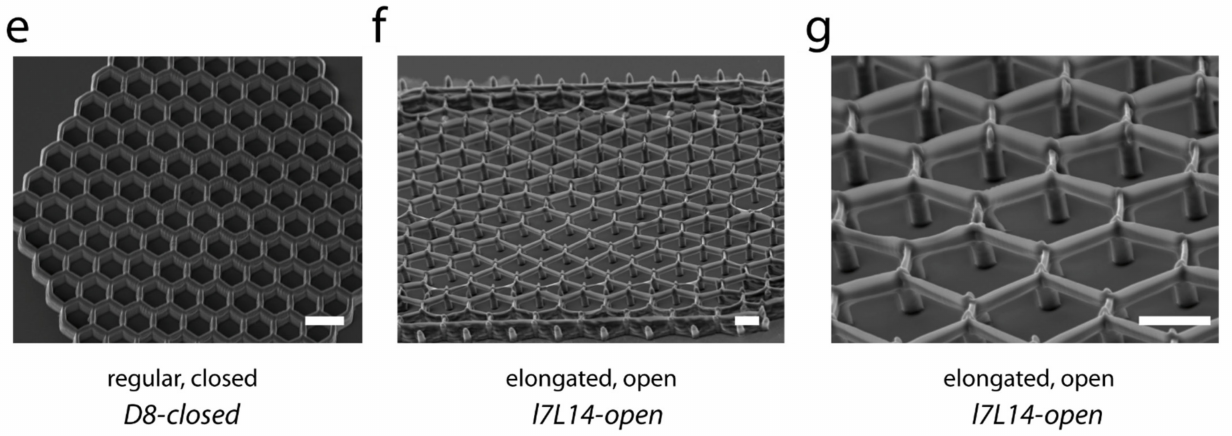
Figure 1. Microfabrication of microstructures. Microstructures were realized with NOA61 (Norland Optical Adhesive) by two-photon polymerization. ( a ) Hexagonal lattices previously described [37] are referred to here as “closed” microstructures. ( b , c ) “Open” microstructures were realized by building hexagons on pillars, with a total height H of 7 µ m (including the typical pillar height of 2–4 µ m), and variable horizontal dimensions. Regular ( b ) and elongated ( c ) hexagons were used. ( d ) Scheme of dimensions measured for regular (D) and elongated (l, L) hexagons. ( e – g ) SEM imaging of D8-closed ( e ) and l7L14-open ( f , g ) structures. ( e ) Top view, ( f , g ) side views, bars 10 µ